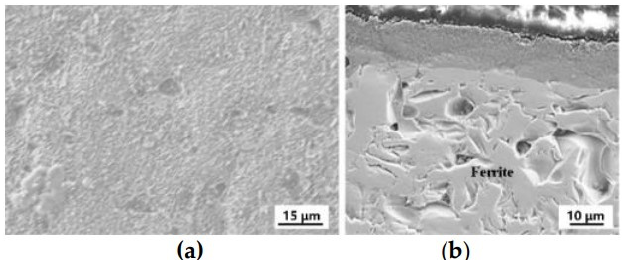
Figure 3. SEM images of MnZn ferrite immersed in molten salt for 2 min: ( a ) surface section; ( b ) cross-section.